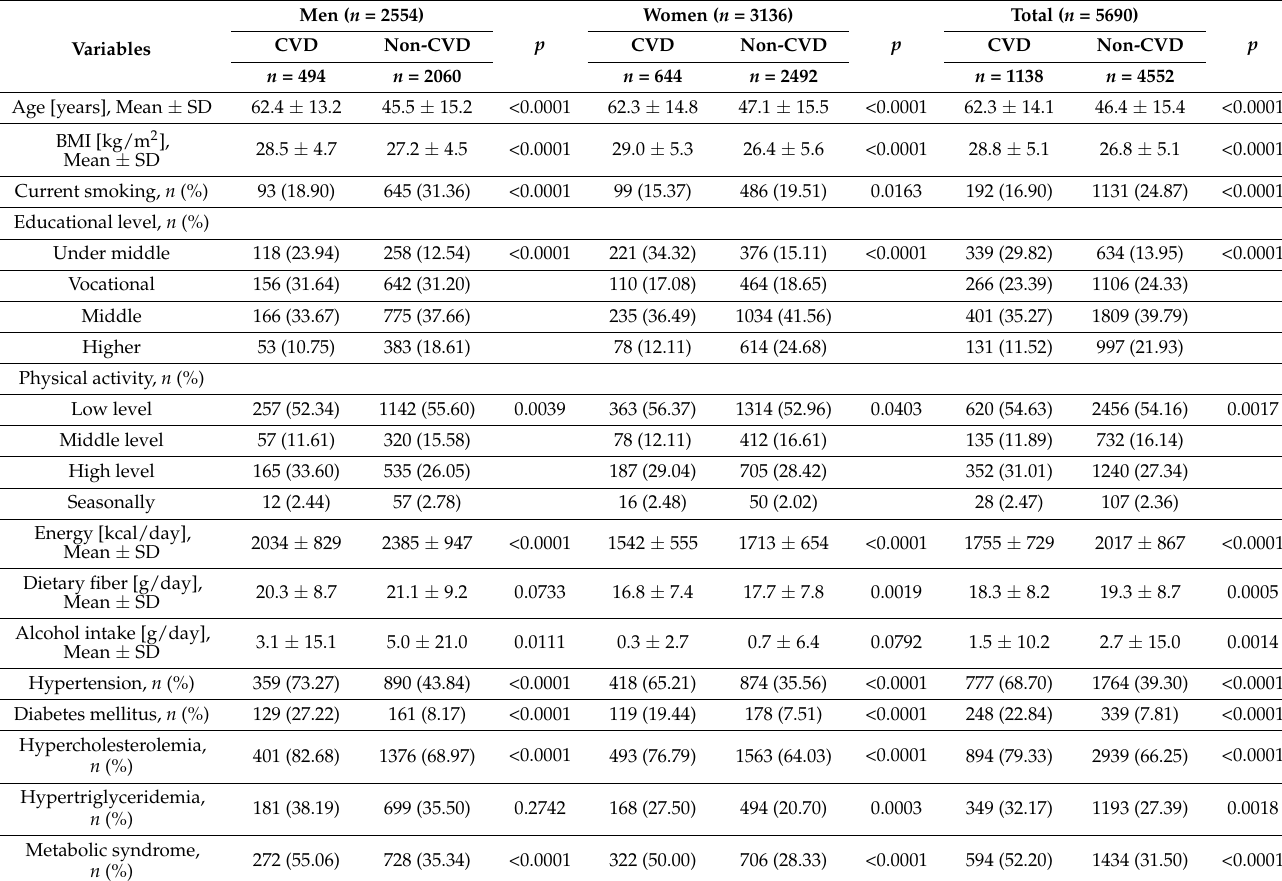
Table 1. Baseline characteristics of the study population according to CVDs for both sexes and